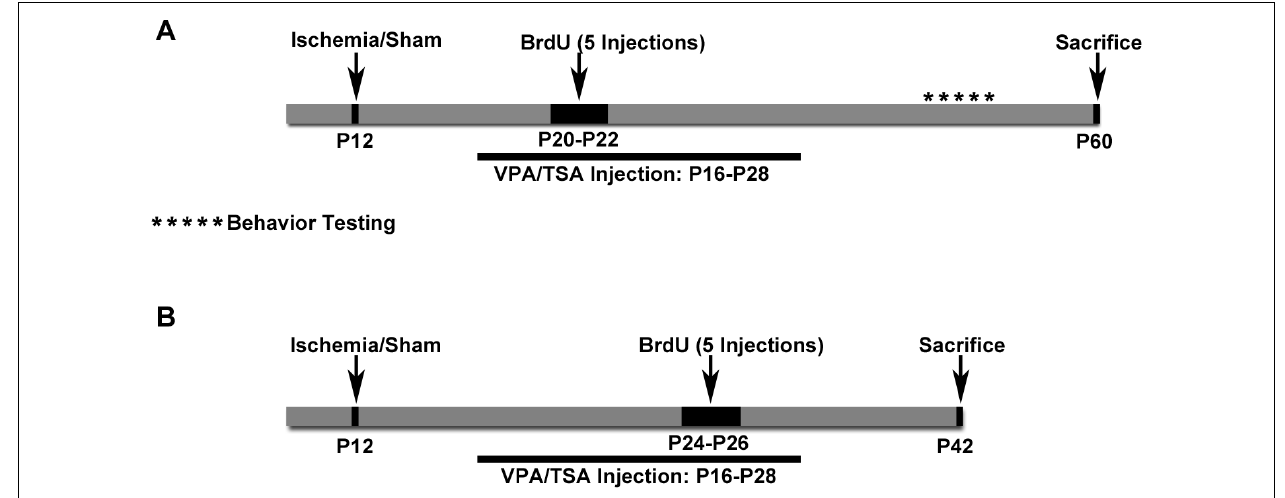
FIGURE 1 | Schematics of Protocols 1 and 2. (A) Schematic for Protocol 1. Cognitive testing was done with these animals. (B) Schematic for Protocol 2. These mice received BrdU later and were euthanized sooner than in Protocol 1.These mice did not have cognitive testing